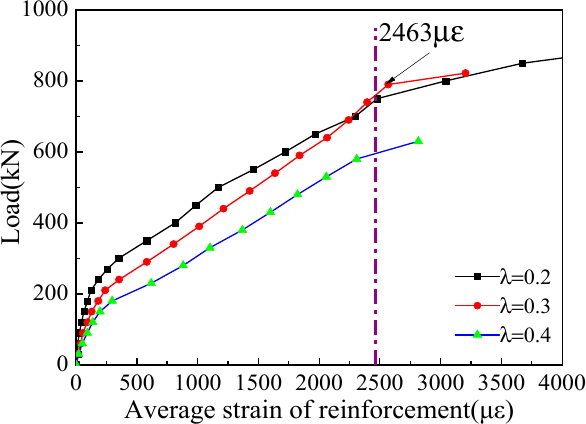
Figure 8. Relationship between load and average strain of longitudinal reinforcement under different λ .